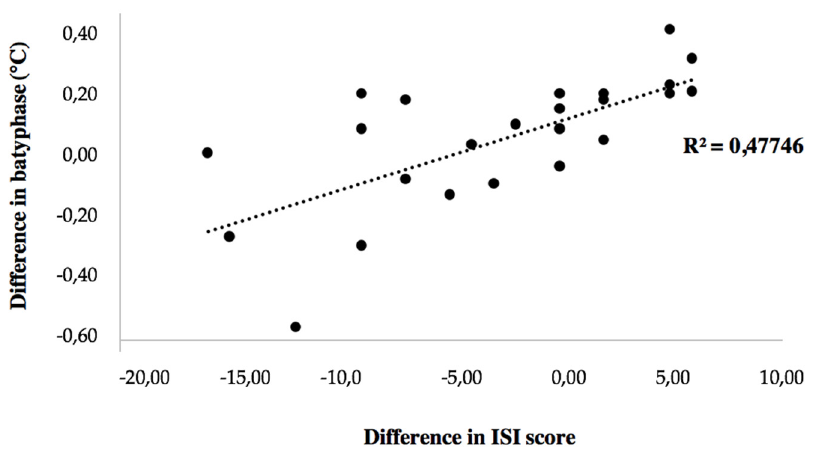
Figure 2. Correlation between change in batyphase and change in ISI score.